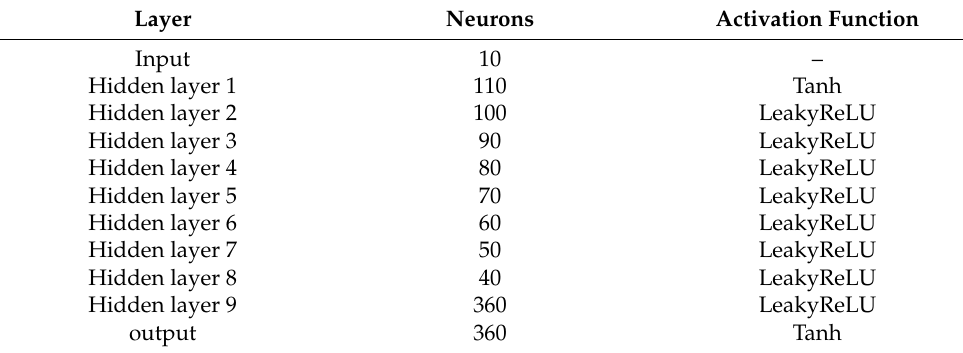
Table 1. DNN network model papameters